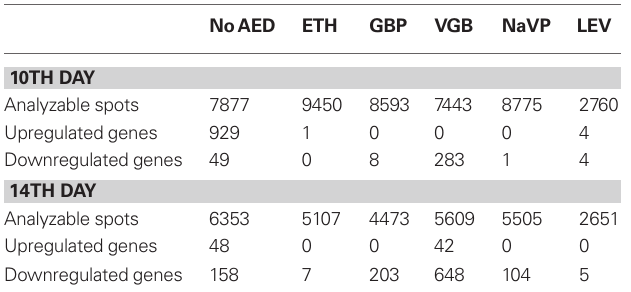
Table 1 | Numbers of SAM analyzable spot iDs and differentially expressed genes in microarray profiles of flies treated with or without AeDs after PTZ